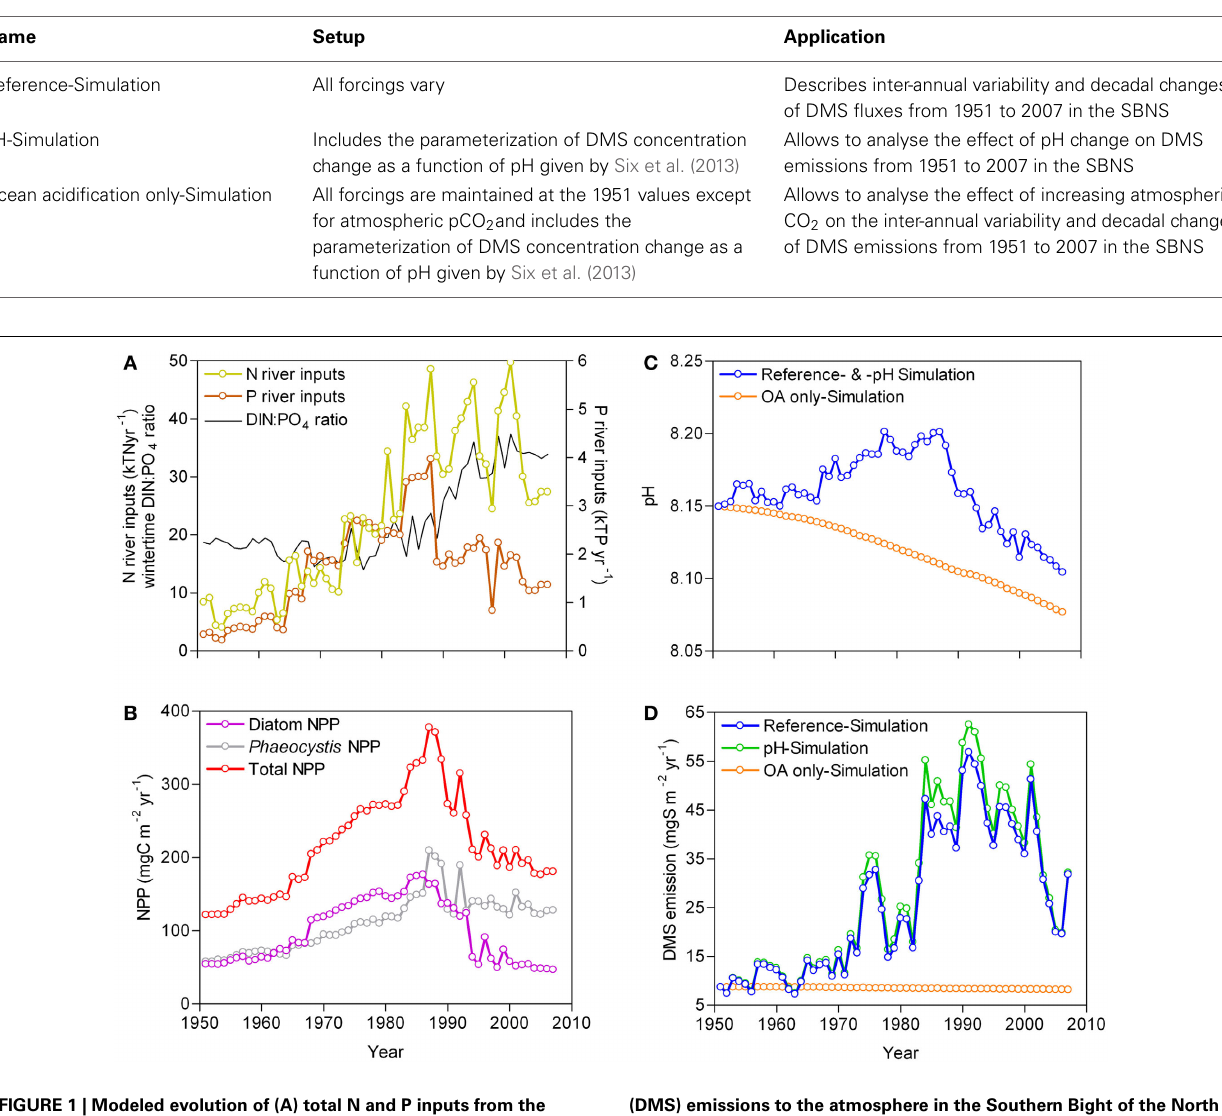
FIGURE 1 | Modeled evolution of (A) total N and P inputs from the Scheldt river and wintertime DIN:PO 4 ratio, (B) net primary production (NPP) from diatoms and Phaeocystis , (C) pH, and (D) dimethylsulfide